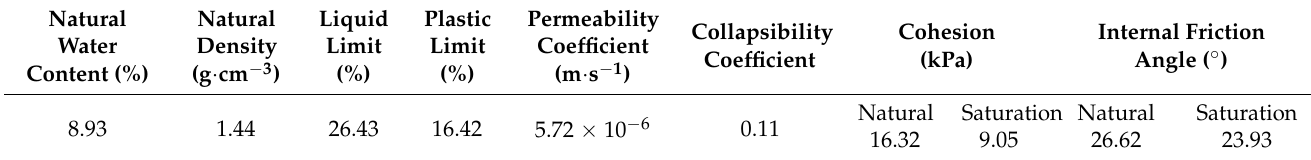
Table 1. Physical and mechanical characteristics of loess.